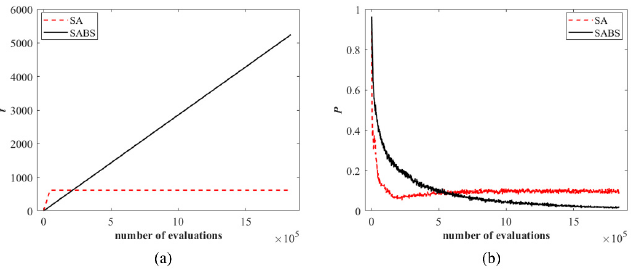
Figure 2. The comparison between SA and SABS. ( a ) The count of temperature change versus the number of evaluations. ( b ) The probability versus the number of evaluations.